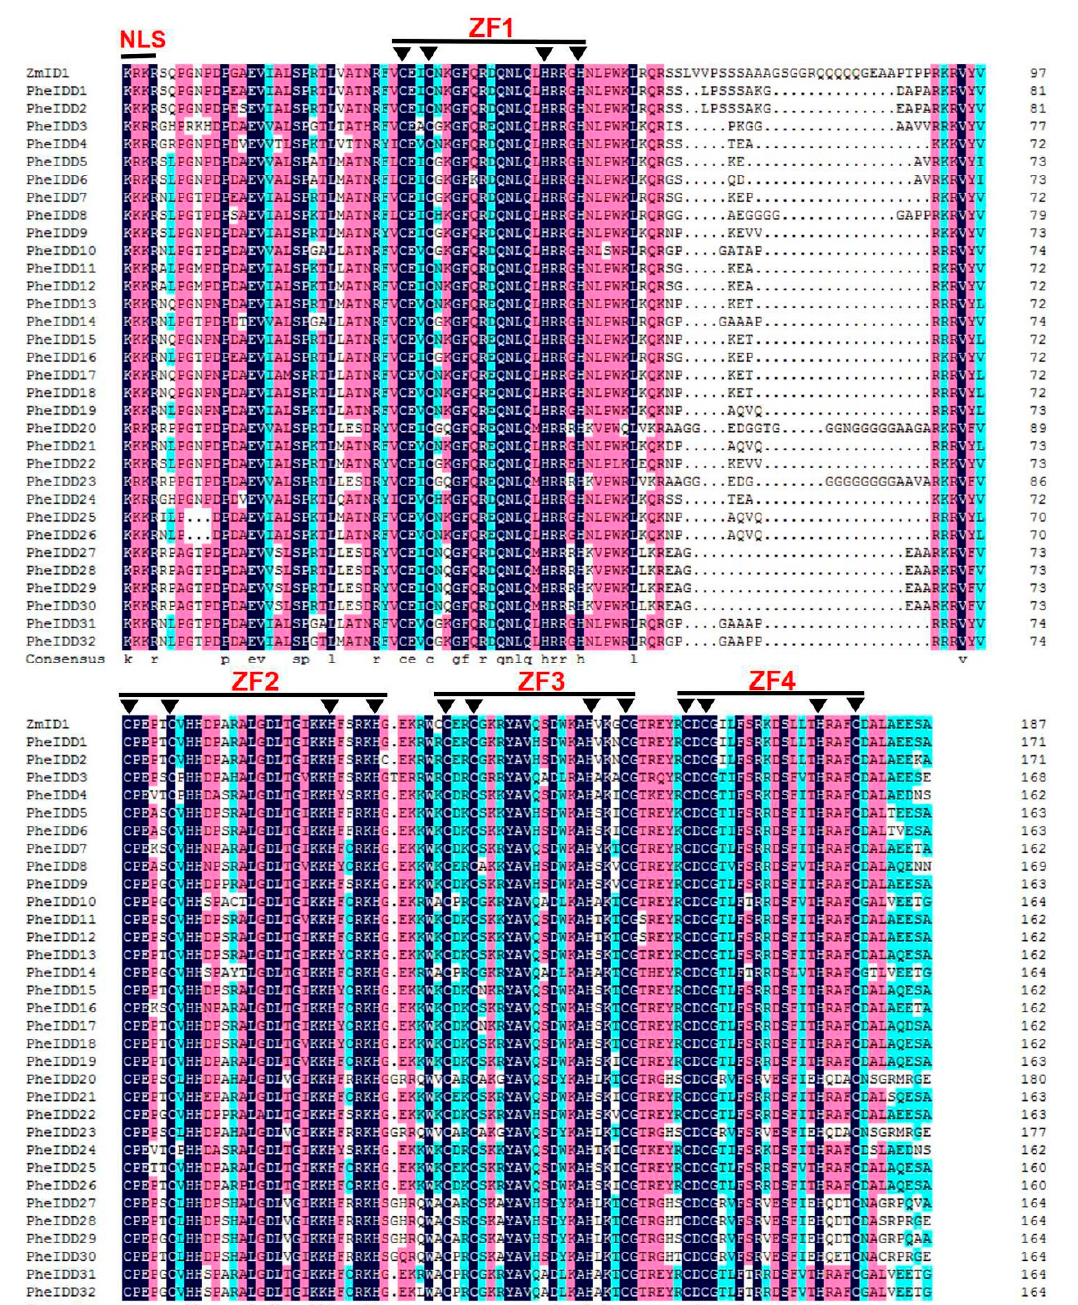
Figure 2. Alignment of amino acid sequences of 32 PheIDDs and ZmID1 proteins. The four zinc-finger motifs are marked with straight lines. Inverted triangles indicate conserved amino acids, CCHH in ZF1 and ZF2, and CCHC in ZF3 and ZF4. NLS at the N-terminal region shows the putative NLS motif. Identical amino acids are shown with text on a black background.